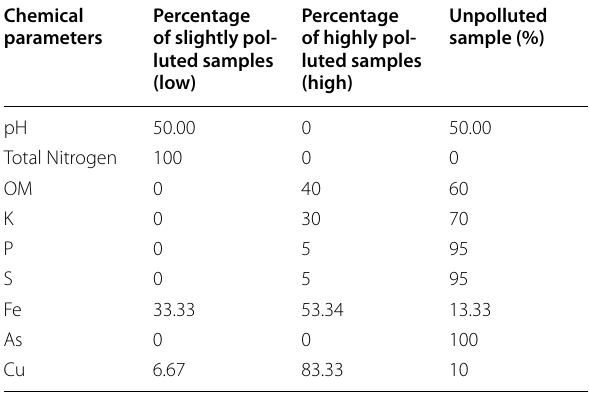
Table 7 The ANOVA test showing the mean differences Table 8 The percentage of polluted and unpolluted soil